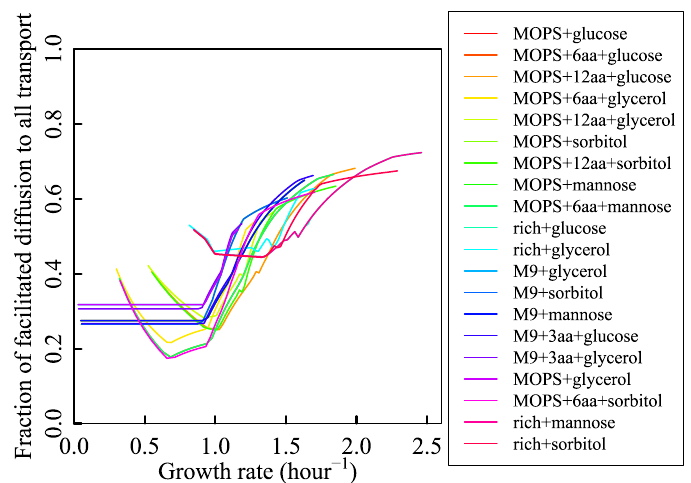
Figure A8. The tendency that the fraction of facilitated diffusion to all transport reactions varies with growth rate. Despite that there are several parts of lines corresponding to the culture media with more than six kinds of amino acids decreased in a small rang of growth rate, the fraction of facilitated diffusion to all transport reactions mainly has a tendency to increase with growth rate and to reach a limit value finally. The data in this figure was obtained by flux balance analysis with bounds listed in Table S1, the same as in Figure